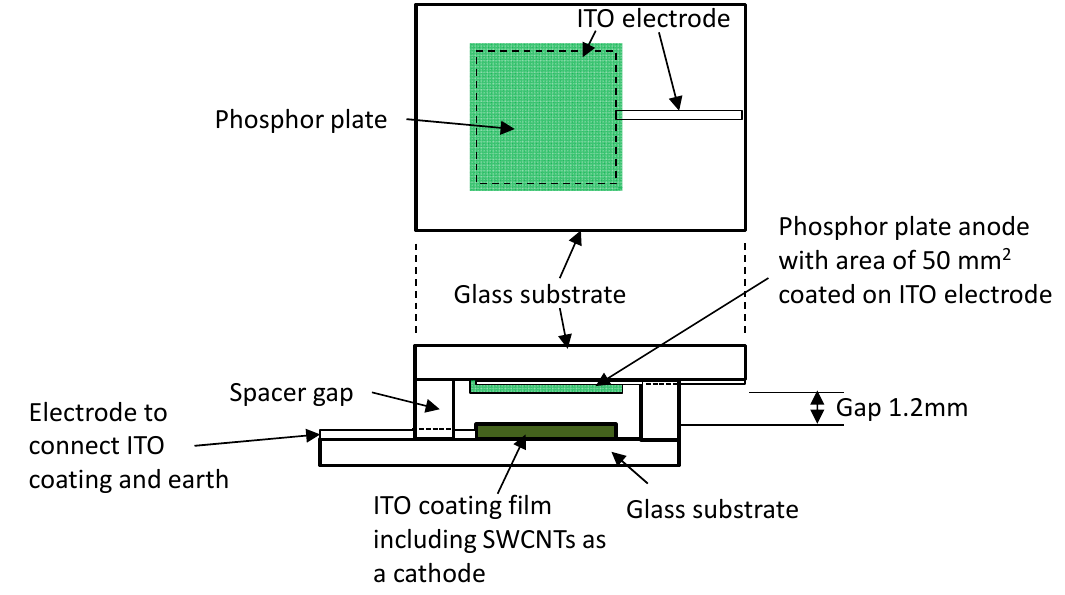
Figure 2. Schematic diagram of the FE measurement system with a diode structure.